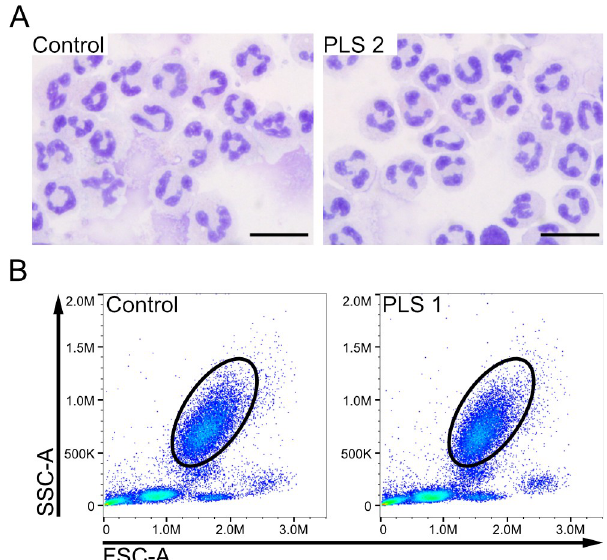
Fig 1. Cytospins of isolated neutrophils and flow cytometry scatter plots of leukocytes samples. (A) Representative micrographs of isolated neutrophils from PLS 2 and a healthy control. Neutrophils were fixed on glass coverslips with a cytocentrifuge and stained with Giemsa and May-Gru¨nwald staining. Magnification, 100x. Scale bars, 10 μ m. (B) Whole blood samples were treated with FACS lysing solution and measured in a flow cytometer. Presented here through forward- and side-scatter for size and granularity, respectively. The gates highlight the granulocyte population in the samples.